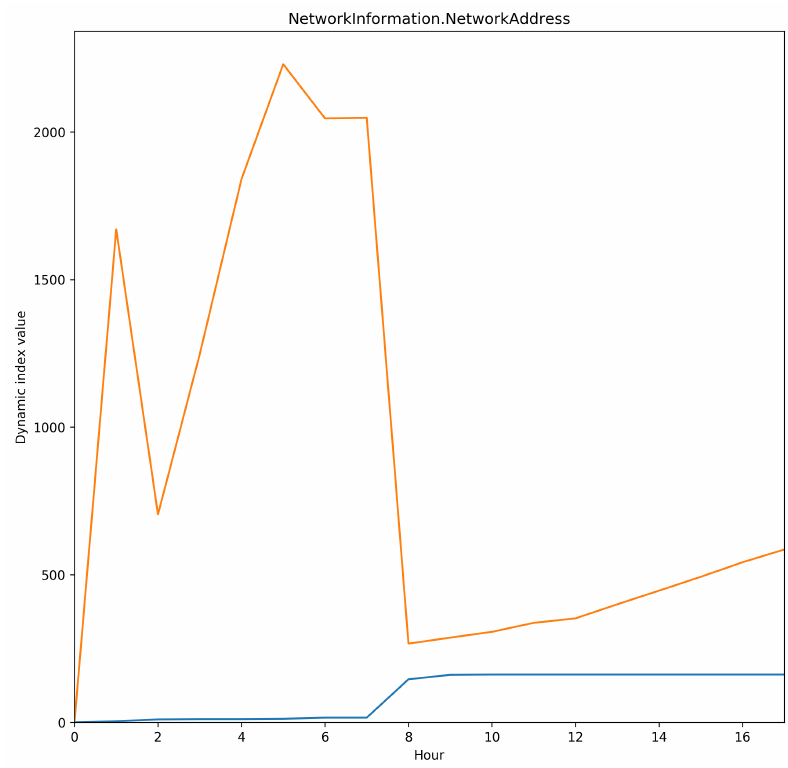
Figure 4. Dynamic indexes for the NetworkInformation.NetworkAddress event property.